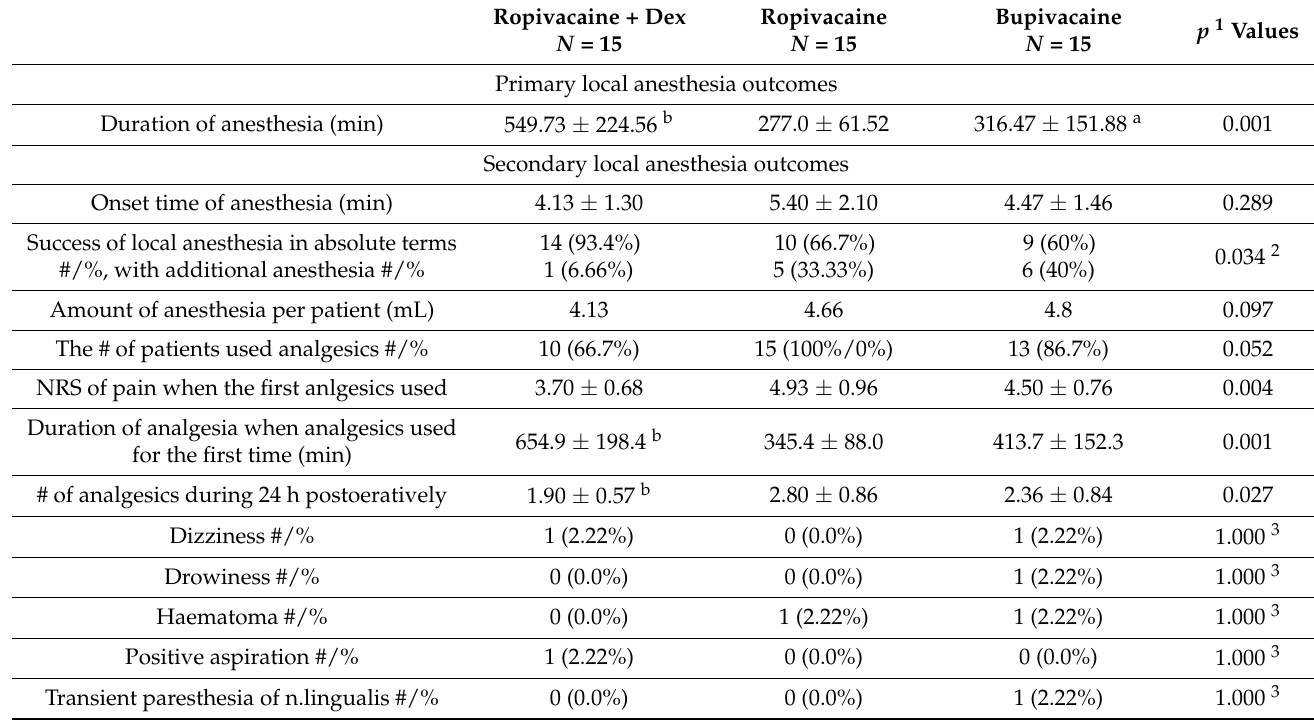
Table 2. Collected parameters for separated primary local anesthesia outcomes and observed sec- ondary outcomes. Ropivacaine + Dex N = 15